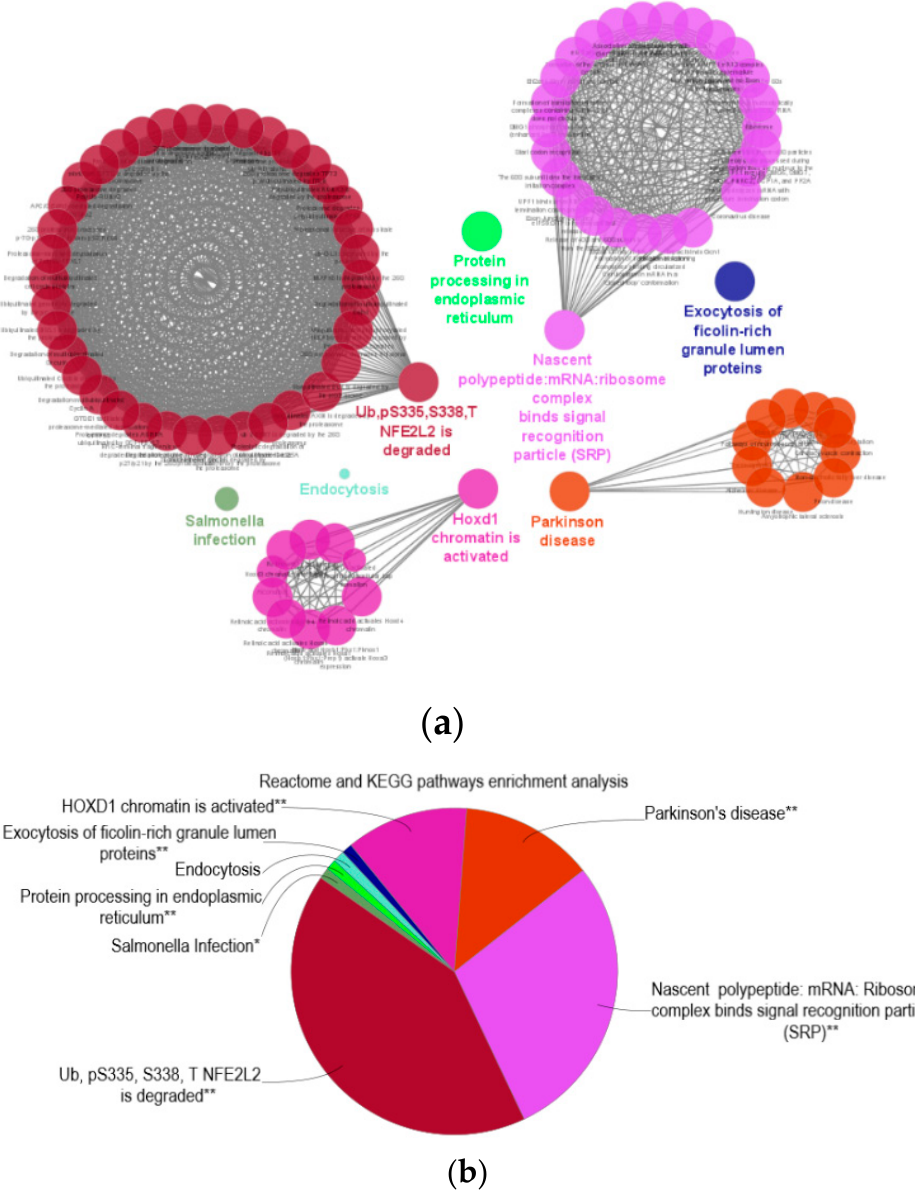
Figure 10. Signal interactions and pathway enrichment analysis. ( a ) DEGs of Tg versus WT were analyzed to identify the Reactome and KEGG pathways in which they involved by using Cytoscape with ClueGo. A total of seven significant identified pathway clusters were labelled in colored letters. A representative pathway for each cluster was selected by the percentage of genes involved per term as well as the number of genes matched in the term. ( b ) Pie chart of identified pathways based on Reactome and KEGG pathways. Seven significant pathways (group p value corrected with Bonferroni step down) were marked with asterisk (** for p < 0.01 and * for p < 0.05) among eight total pathways.